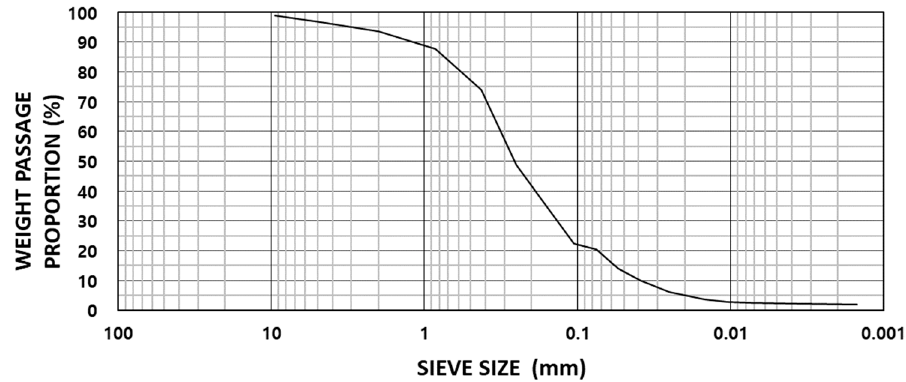
Figure 1. Particle size distribution curve of multi-contaminated soil sample (ASTM D-6913 [10]).